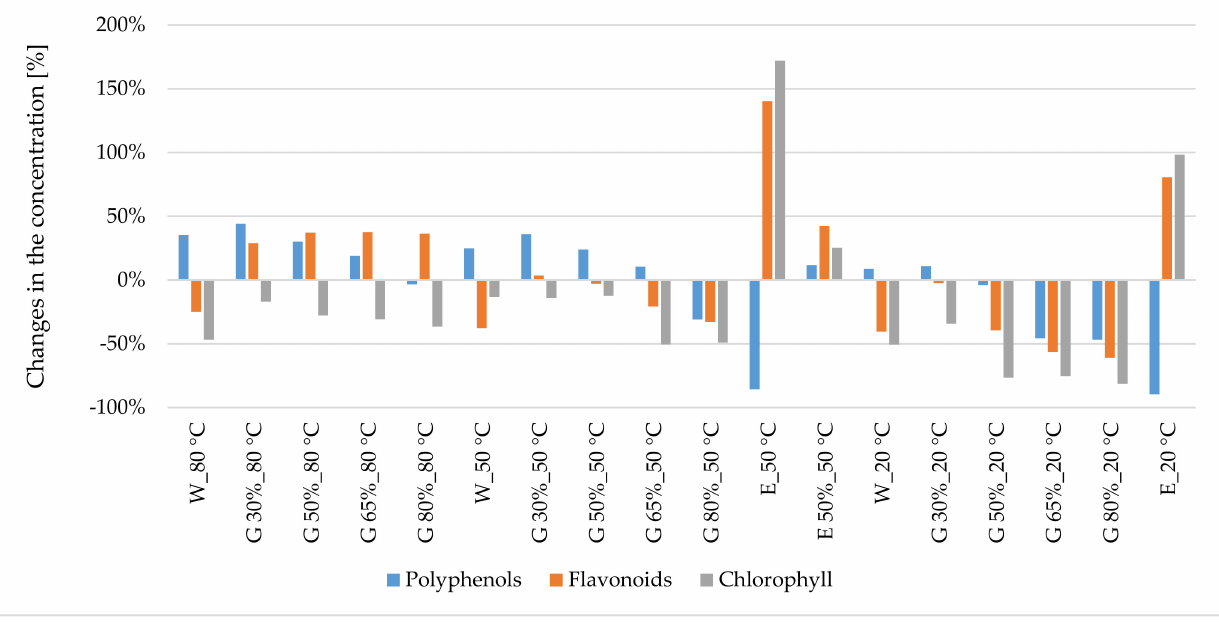
Figure 1. Changes (%) in the concentration of polyphenols, flavonoids and chlorophyll in extracts from peppermint leaves compared with 50% ethanol–water extract (20 ◦ C). W—water, G—glycerol. Sample code—designations as in Table